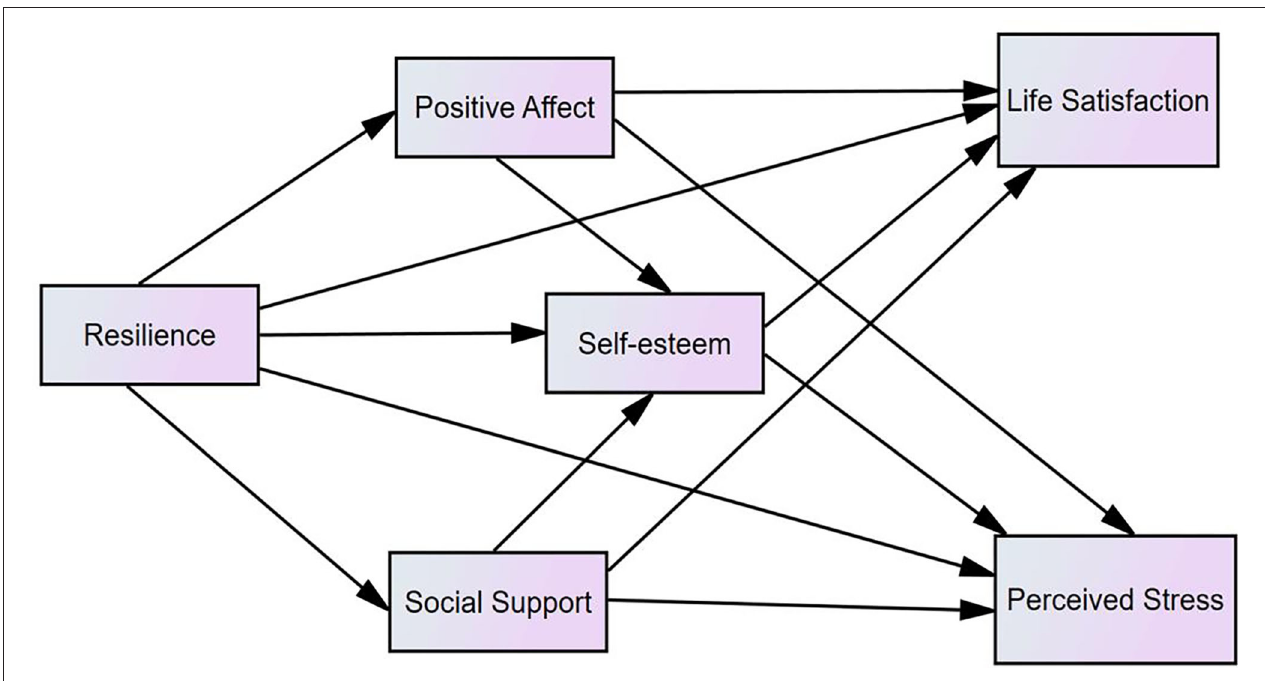
FIGURE 1 | The hypothesized model ( N =